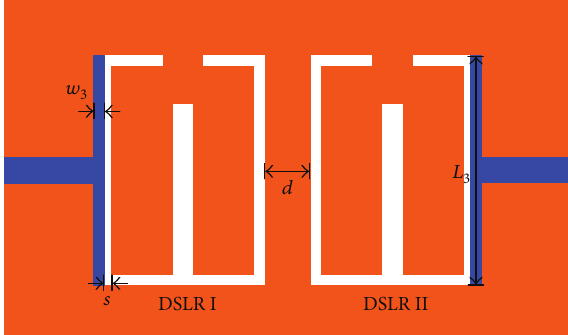
Figure 4: Configuration of the proposed DSLR dual-band filter.